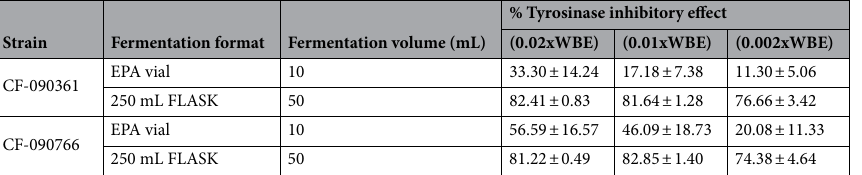
Table 2. Anti-tyrosinase activity of CF-090361 and CF-090766 extracts (7 days of incubation). *Each fermentation condition was performed in ten repetitions (n = 10).